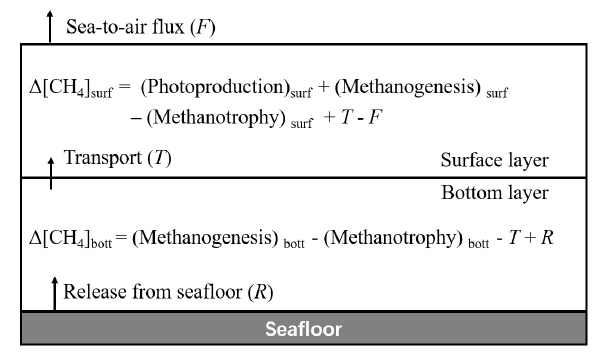
FIGURE 6 | A box model sketching CH 4 dynamics in stratified coastal oceans without river plumes (subscript surf stands for the surface layer, bott for the bottom layer, T for upward transport across the thermocline, F for sea-to-air flux, and R for release from the